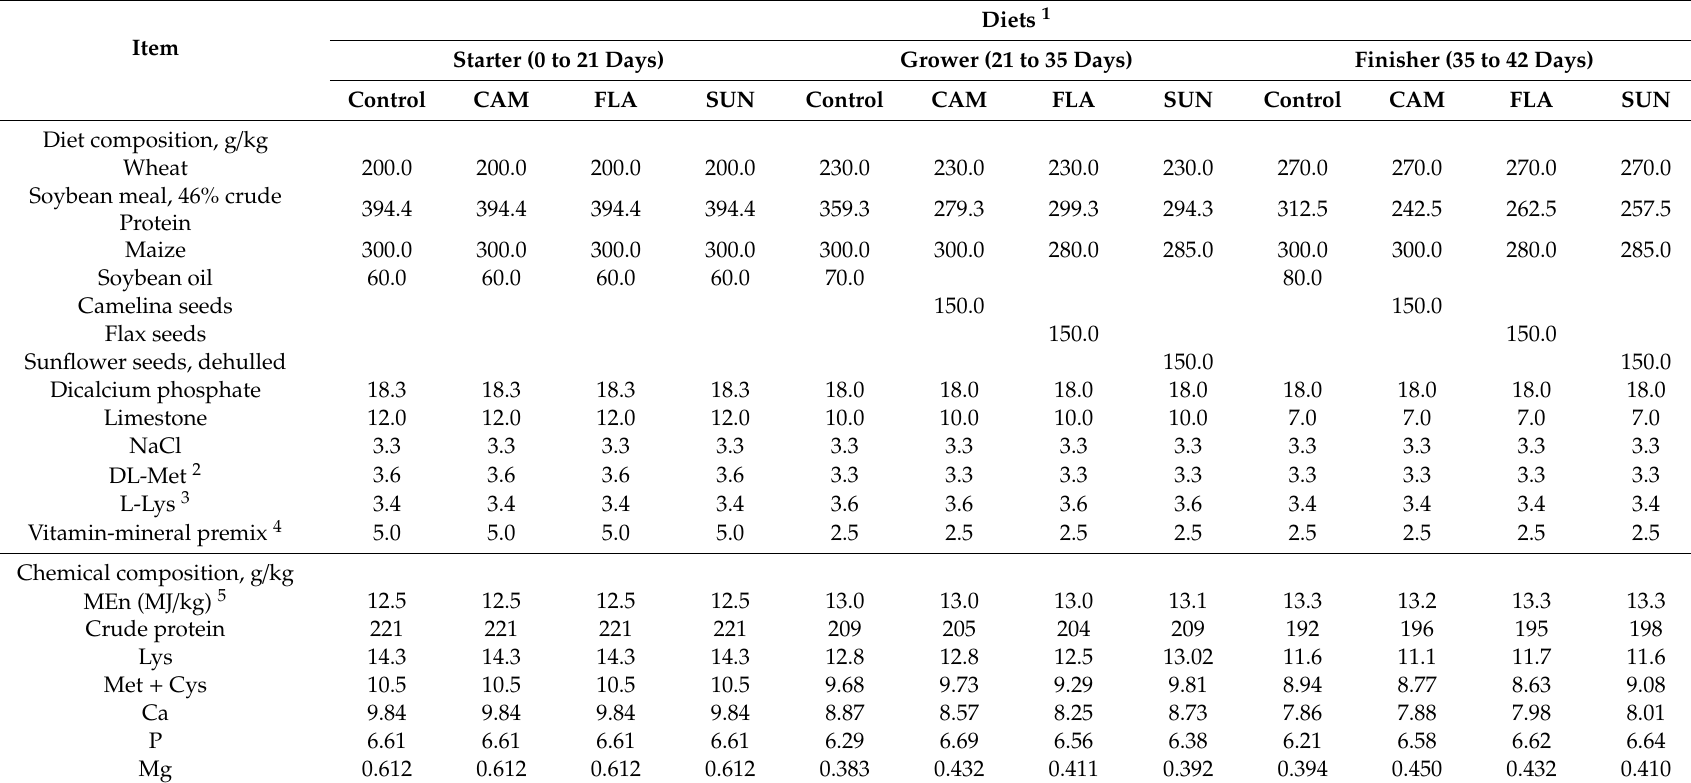
Table 2. Ingredients and chemical composition (g / kg, as a fed basis) of experimental